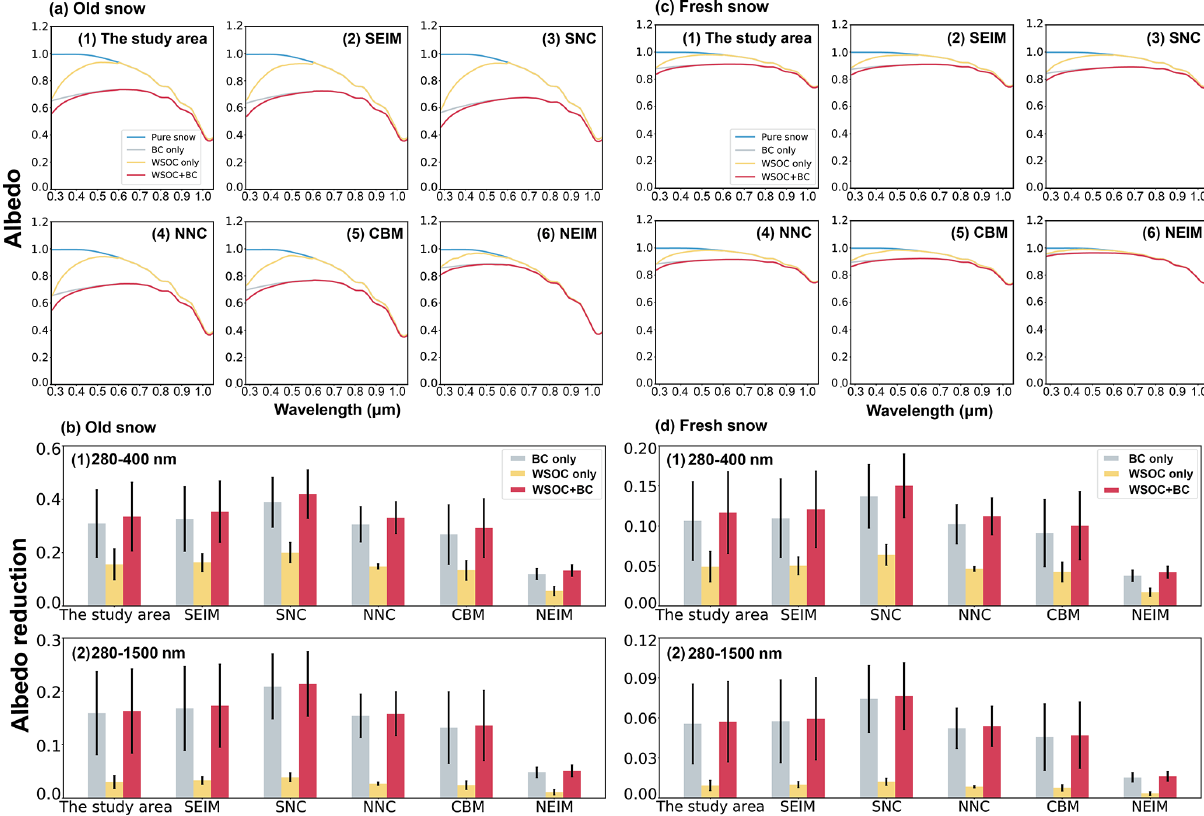
Figure 8. (a–b) : Simulated snow spectral albedo and broadband albedo reductions – under various contamination scenarios and for different regions – for old snow (radius = 1000µm). (c–d) Simulated snow spectral albedo and broadband albedo reductions – under various contam- ination scenarios and for different regions – for fresh snow (radius = 100µm). Colors represent the different types of snow (pure snow, BC- or WSOC-contaminated snow, and snow polluted by both WSOC and